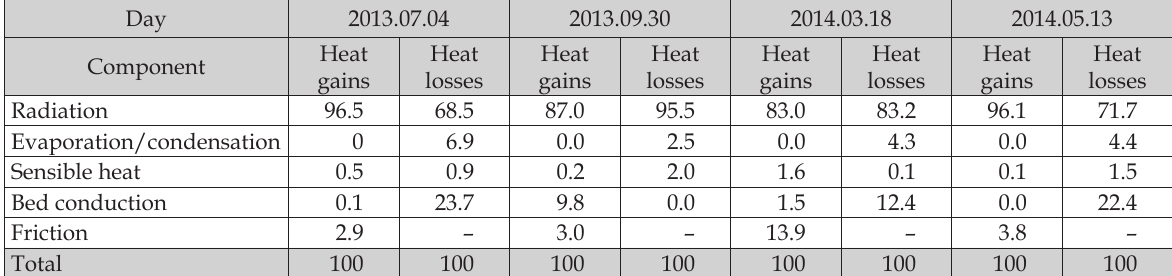
Table. 4. Average percentage contributions of heat gains and losses in energy budget of the Świder River (%)